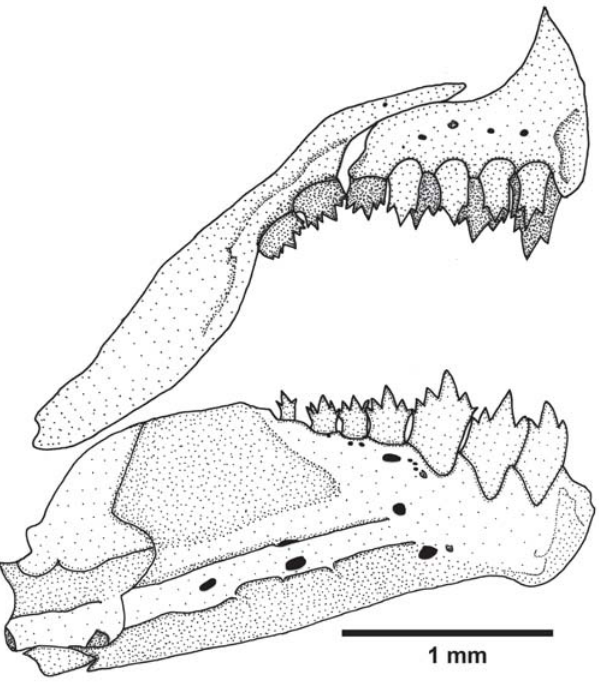
Fig. 2. Knodus shinahota , paratype, LIRP 5723, 38.9 mm SL. Upper and lower jaws, right side, lateral